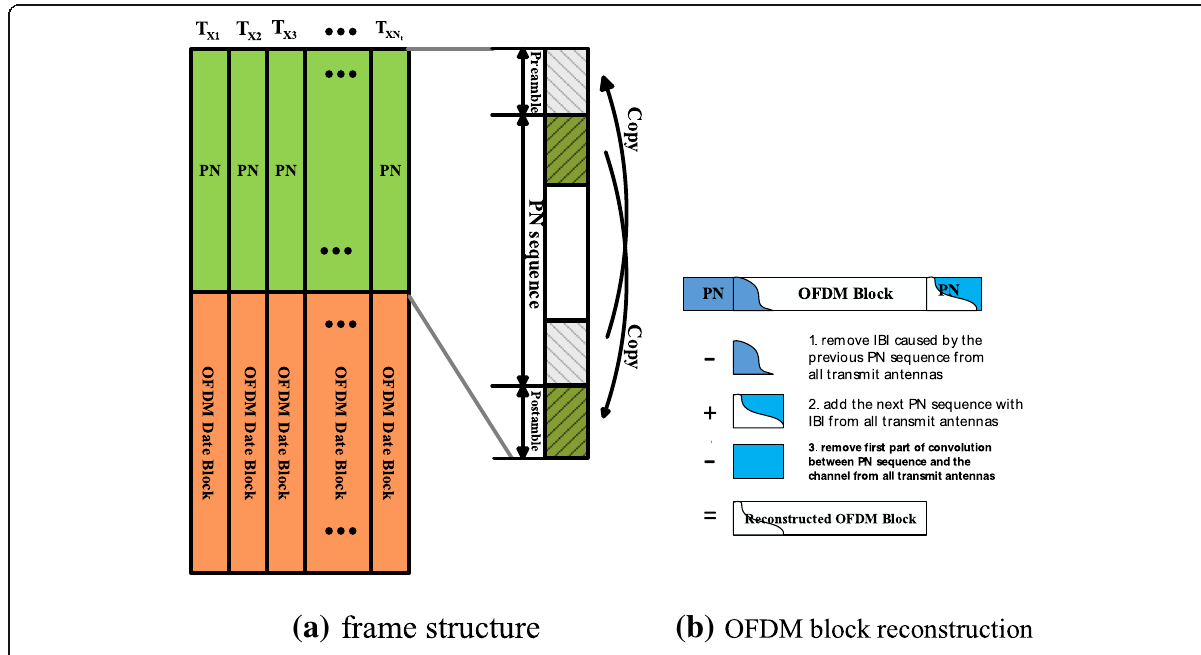
Fig. 1 The existing OFDM frame structure